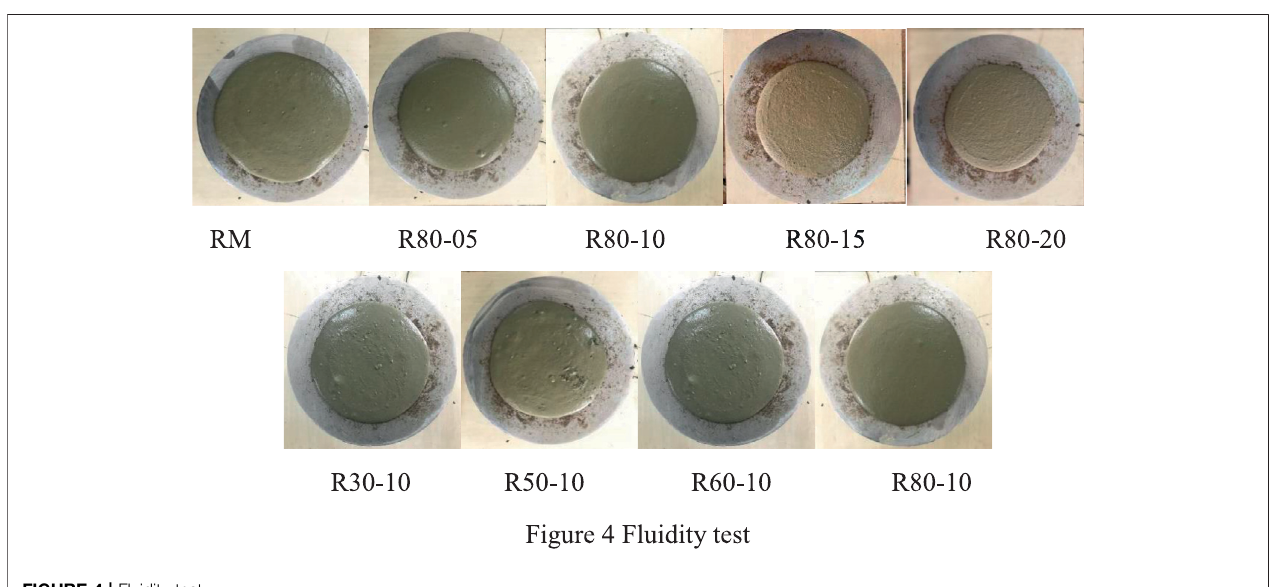
FIGURE 4 | Fluidity